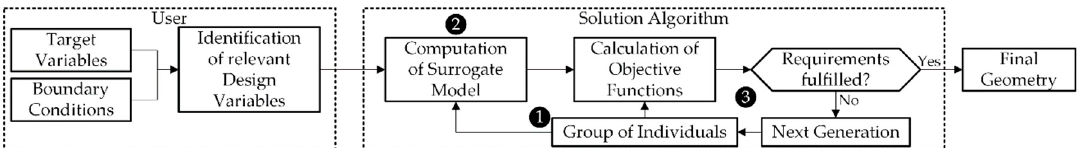
Figure 4. Stochastic method with surrogate model. Distinct properties are numbered and